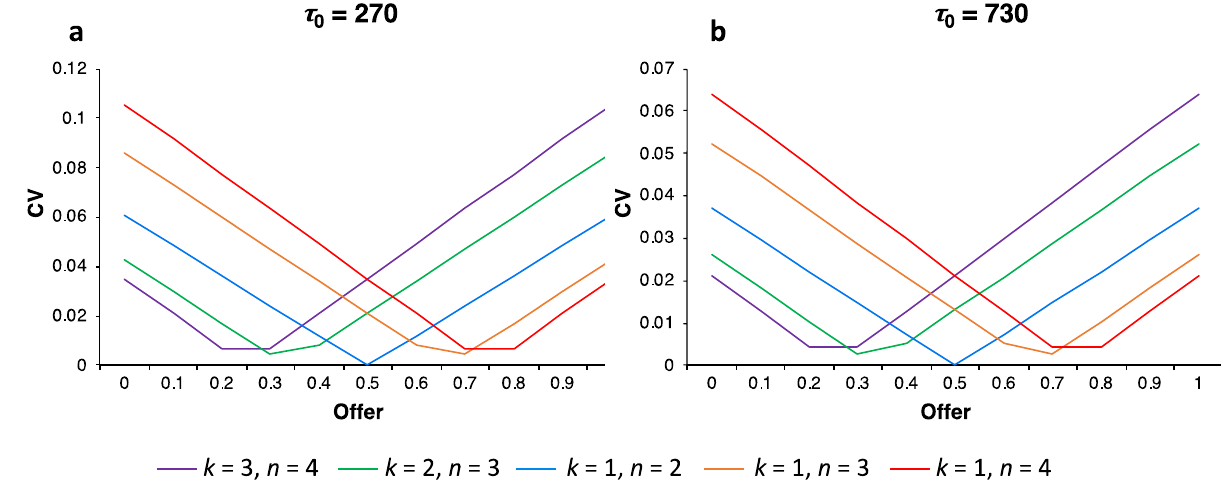
Figure 2. Accumulated resource variation as measured by coefficients of variation for the five DG k , n . For all but DG 1,2 , minimal coefficients of variation are not achieved because the minimum is achieved only when p = 1 − k / n , which does not always correspond to values in the range p = 0, …, 1.0 in increments of 0.1. Note that while accumulated resource variation for τ 0 = 270 ( a ) and τ 0 = 730 ( b ) have the same form, the range of the relative variation for τ 0 = 270 is higher than for τ 0 =